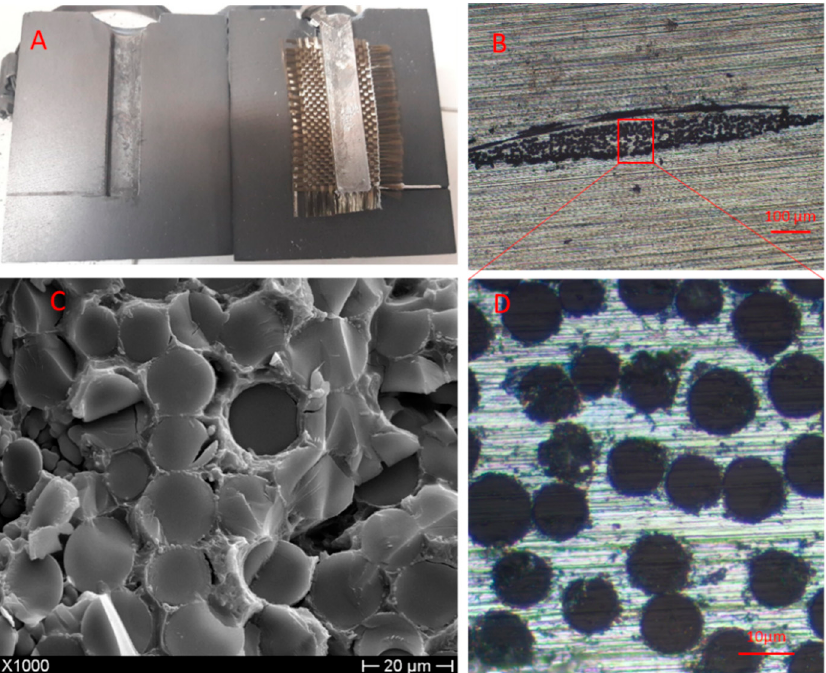
Figure 4. ( A ) Sample after casting with long fillers. ( B ) Cutting surface of sample with long fillers. ( C ) Fracture surface of sample with long fillers. ( D ) Enlargement of cutting surface in ( B ).